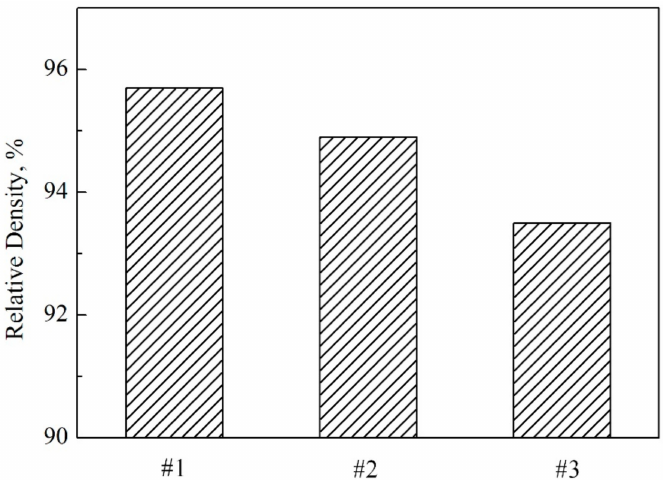
Figure 3. Relative density of the Si 3 N 4 –MoSi 2